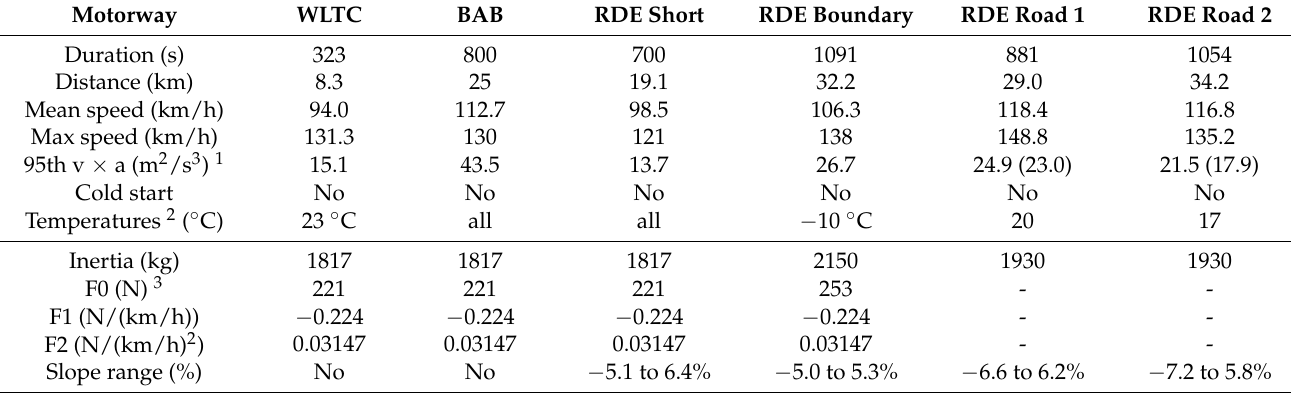
Table A3. Characteristics of the motorway cycle (BAB), the extra-high part of WLTC and the motorway parts of the RDE